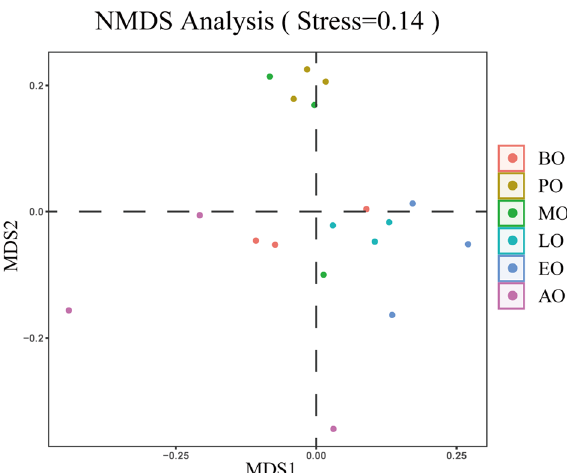
Figure 6. The result of Nonmetric multidimensional scaling analysis. The points in the graph represent the samples, the samples with different colors belong to different groups, and the distance between the points indicates the degree of difference between the